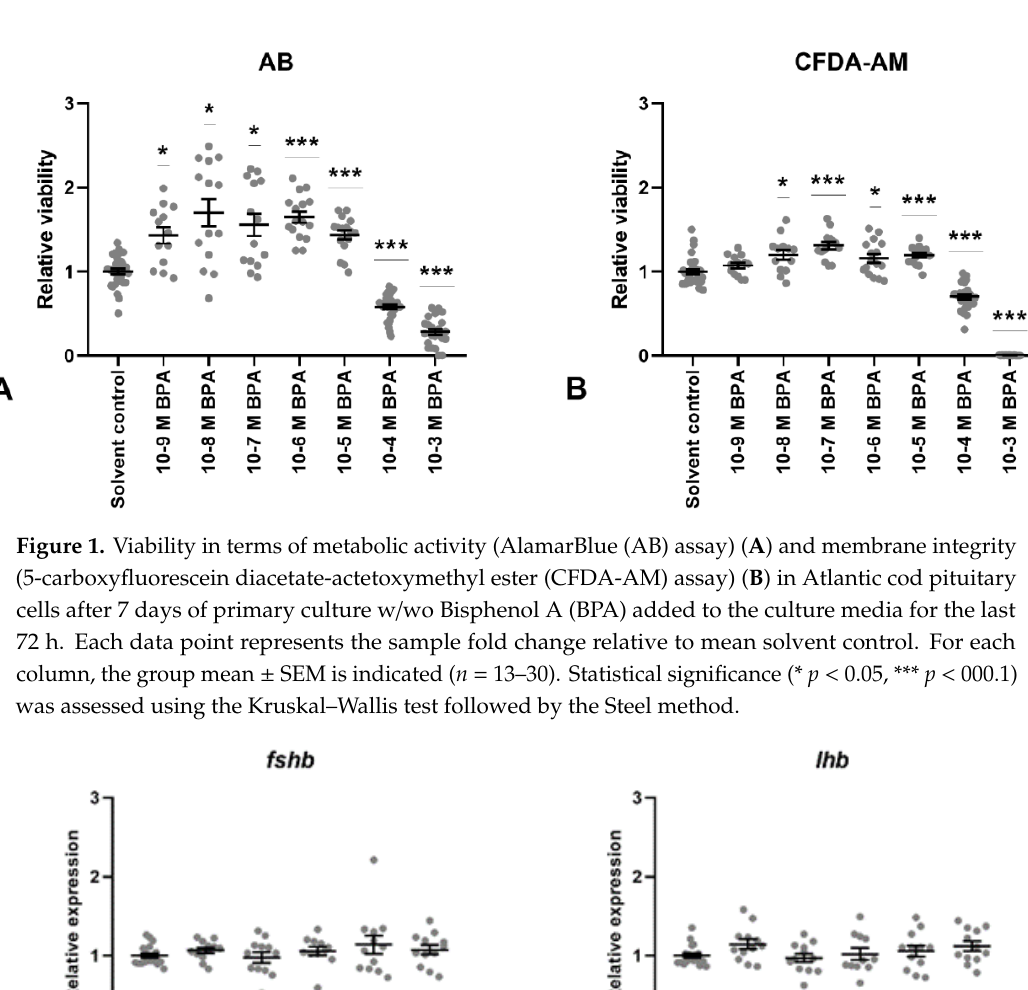
Figure 3. Gene expression of two gonadotropin-releasing hormone receptors ( GnRHr1b ; ( A ), GnRHr2a ; ( B )) in Atlantic cod pituitary cells after 7 days of primary culture w/wo BPA added to the culture media for the last 72 h. Each data point represents the sample fold change relative to mean solvent control. For each column, the group mean ± SEM is indicated ( n = 11 – 18). Statistical significance (* p < 0.05, *** p < 000.1) was assessed using a one- way ANOVA followed by Dunnett’s method. 3.3. TBBPA Exposure All experimental doses of TBBPA (10 − 9 M to 10 − 4 M) significantly affected cell viability, both in terms of metabolic activity and membrane integrity (Figure 4A,B, respectively). As with BPA, a hormesis effect was detected for both parameters. TBBPA cytotoxicity appeared ten times more potent than that of BPA on these cells, as negative effects were detected from 10 − 5 M TBBPA. At 10 − 4 M, no membrane integrity was detected. At 10 − 5 and 10 − 4 M, no cellular outgrowths were visible through the microscope.